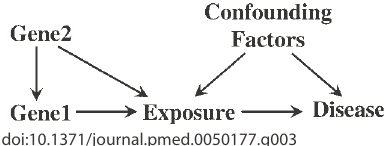
Figure 3. A Mendelian Randomisation Study Where the Chosen Instrument Is in Linkage Disequilibrium with a Variant That Is Also Causal for the Intermediate Exposure